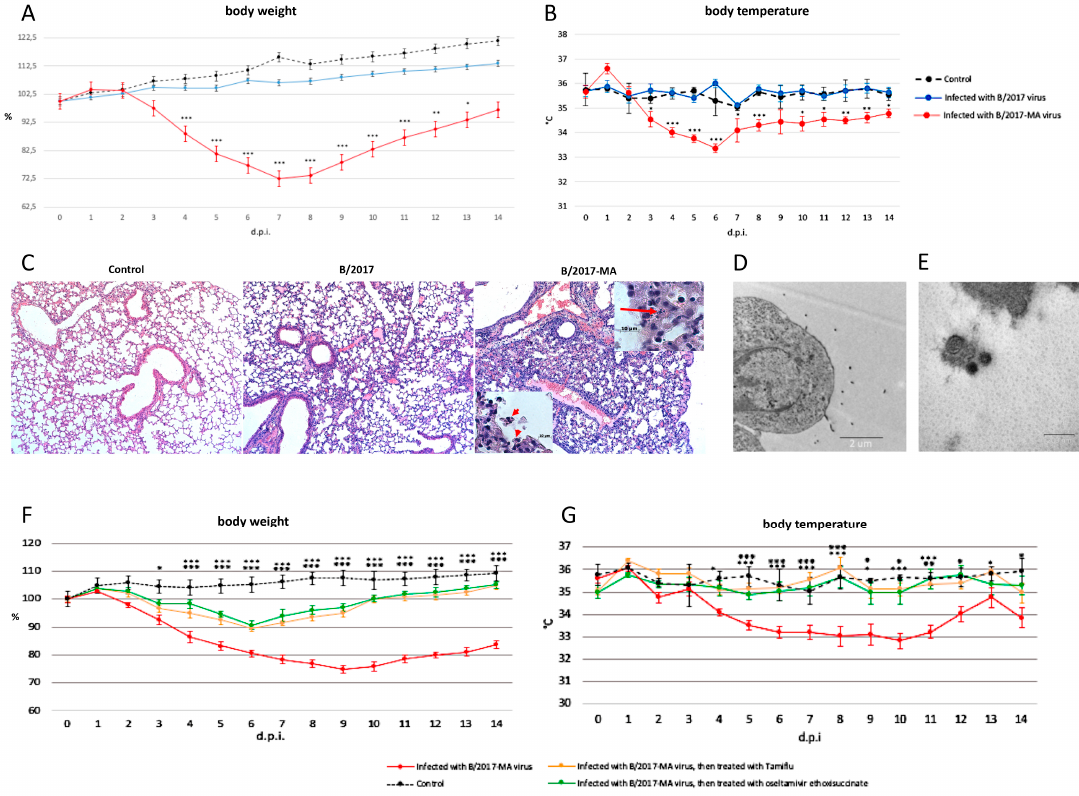
Figure 2. Comparative analysis of B / 2017 and B / 2017-MA strains, and assessment of anti-influenza drugs against mouse-adapted influenza B virus in vivo. Note: ( A ) body weight and ( B ) body temperature; intact mice received phosphate-bu ff ered saline (PBS) (dotted black line); mice intranasally infected with 10 4 TCID 50 (50% tissue culture infective dose) of B / 2017 strain (blue line); mice intranasally infected with 10 MID 50 (mouse infectious dose) of B / 2017-MA strain (red line). (cid:63) p < 0.05; (cid:63)(cid:63) p < 0.01; (cid:63)(cid:63)(cid:63) p < 0.001, reliability when comparing data from groups of infected mice. ( C ) Lungs from mice euthanized 6 days post inoculation were collected and were preserved in 10% formalin for histopathological examination by hematoxylin and eosin (H&E) staining. Images were taken at × 40 magnification. Insertions: arrows indicate the apoptotic cells. Images were taken at × 1000 magnification. ( D ) Budding of influenza B virions from the surface of type 1 alveolar cells on the 3rd day post infection (d.p.i.) with B / 2017-MA strain. bar = 20 microns. ( E ) Virions of influenza B; bar = 200 nm. ( F ) Body weight and ( G ) temperature of: intact mice who received PBS (dotted black line); mice infected intranasally with 10 MID 50 of B / 2017-MA strain (red line); mice infected with 10 MID 50 of B / 2017-MA strain and treated with Tamiflu ® (orange line); mice infected with 10 MID 50 of B / 2017-MA strain and treated with oseltamivir ethoxysuccinate (green line). (cid:63) p < 0.05; (cid:63)(cid:63) p < 0.01; (cid:63)(cid:63)(cid:63) p < 0.001, reliability when comparing data from groups of infected